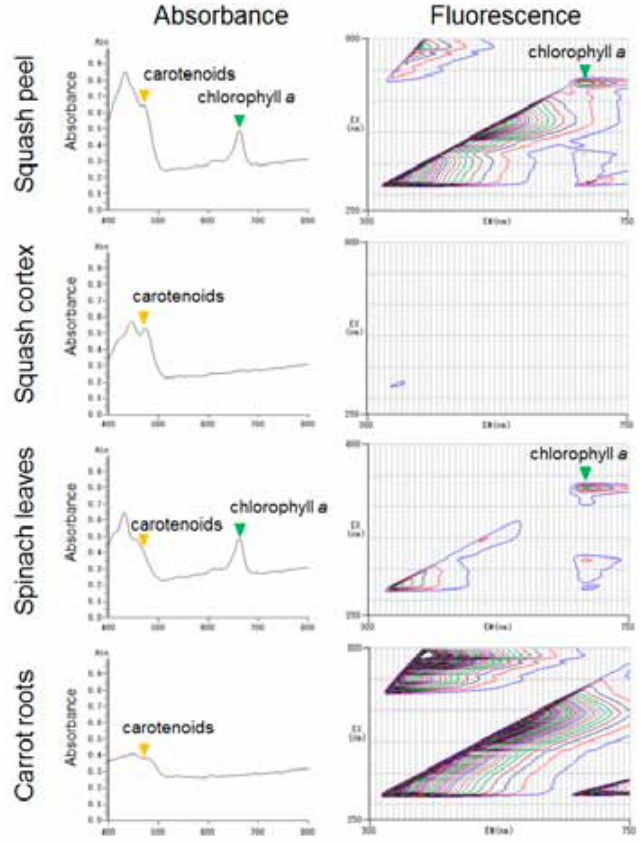
Fig. 4 - Spectroscopic and fluorescent profiles of DME-extracted pig- ments from vegetable samples. Comparison of absorption spectra (left) and fluorescence spectral contour (right) recorded in ex- tracts from squash peel (top), yellow squash cortex (second line from the top), spinach leaves (third line from the top), and carrot roots (bottom). Prior to assays, extracts (oil/water mixtures) ob- tained after evaporation of DME were dissolved in acetone.